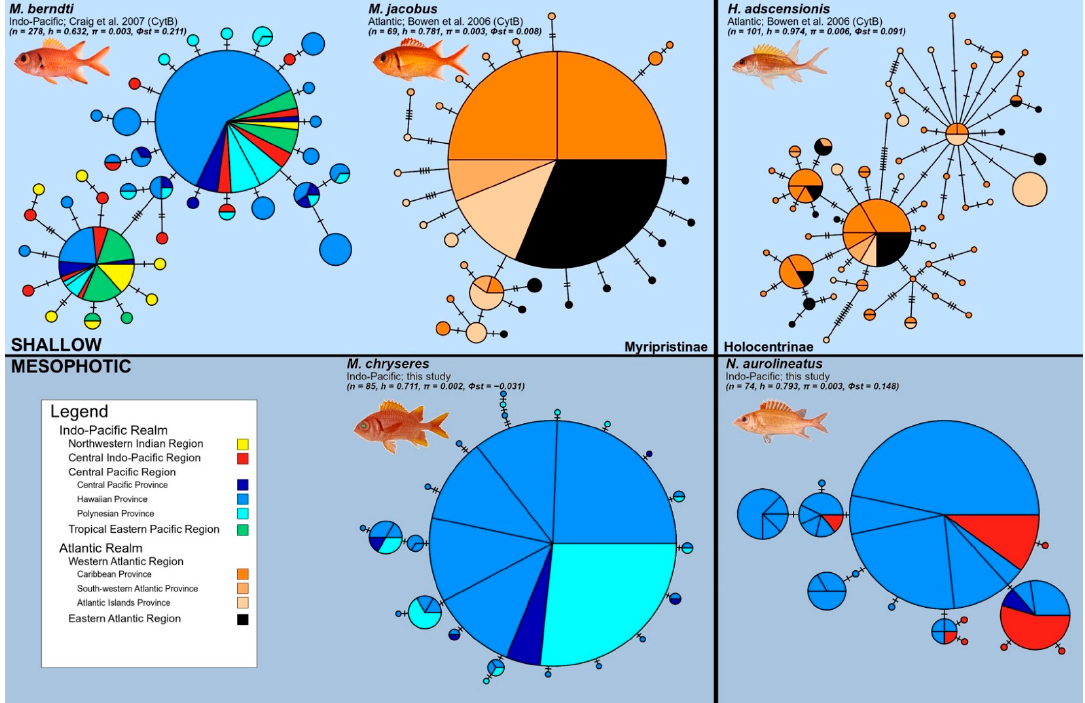
Figure 5. Haplotype networks for five reef-associated holocentrids organized by sub-family and depth strata, including Myripristis berndti , Myripristis jacobus , Neoniphon adscensionis (shallow), and M. chryseres and N. aurolineatus (mesophotic). Circle sizes correspond to the frequency of each sampled haplotype. Plots include ocean basin, data source, sample size, and global population genetic statistics for each sampled species. Colors correspond to biogeographic regions and provinces, as discussed in Kulbicki et al. [62], while circle segments correspond to individual sampling locations. For the M. berndti network (adapted from data in Craig et al. [32]), all Hawaiian sampling locations are grouped into the same segment and all circle sizes are square root-standardized (due to the higher sample size). Photo credits: Jeffrey Williams ( M. berndti, M. jacobus, M. adscensionis ), Barry Hutchins ( M. chryseres ), John Randall ( N. aurolineatus ).